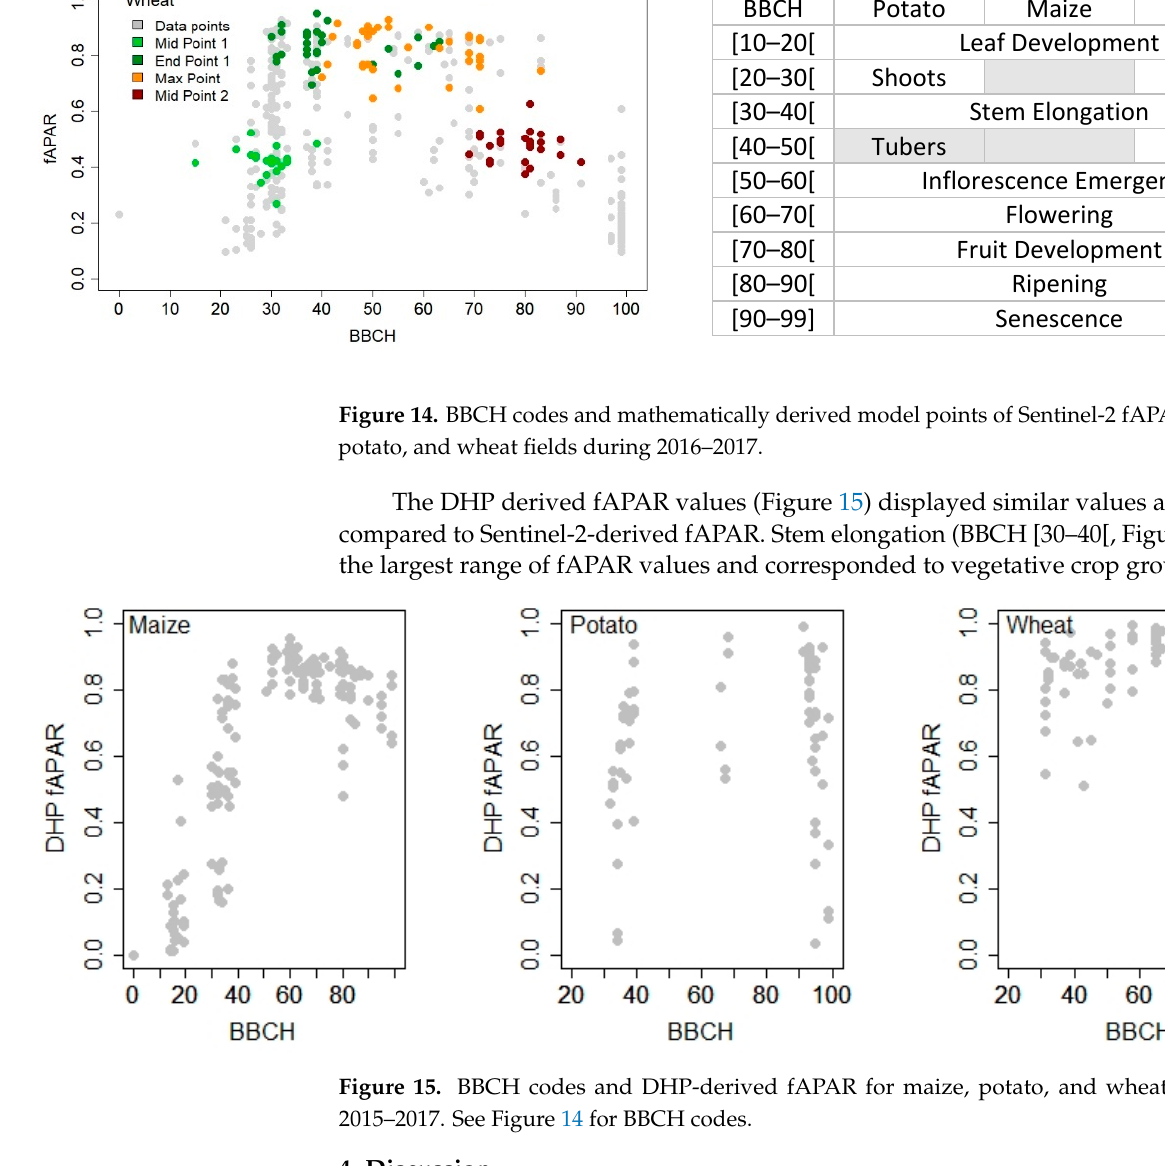
Figure 15. BBCH codes and DHP-derived fAPAR for maize, potato, and wheat for the period 2015 – 2017. See Figure 14 for BBCH codes.